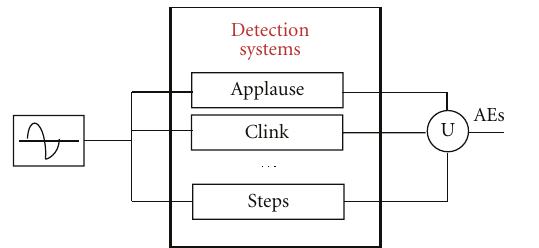
Figure 7: A set of binary detectors working in parallel.